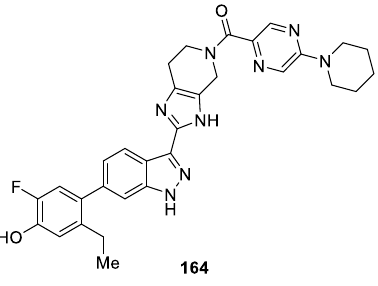
Figure 48. Chemical structure of 1 H -indazole analogue 164 .